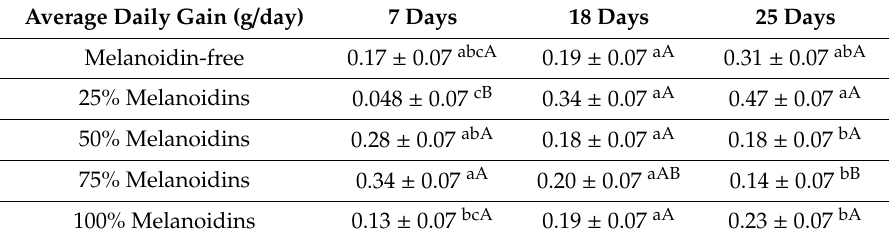
Table 2. E ff ect of diet on average daily weight gain. Data are expressed as mean ± SEM ( n = 15).